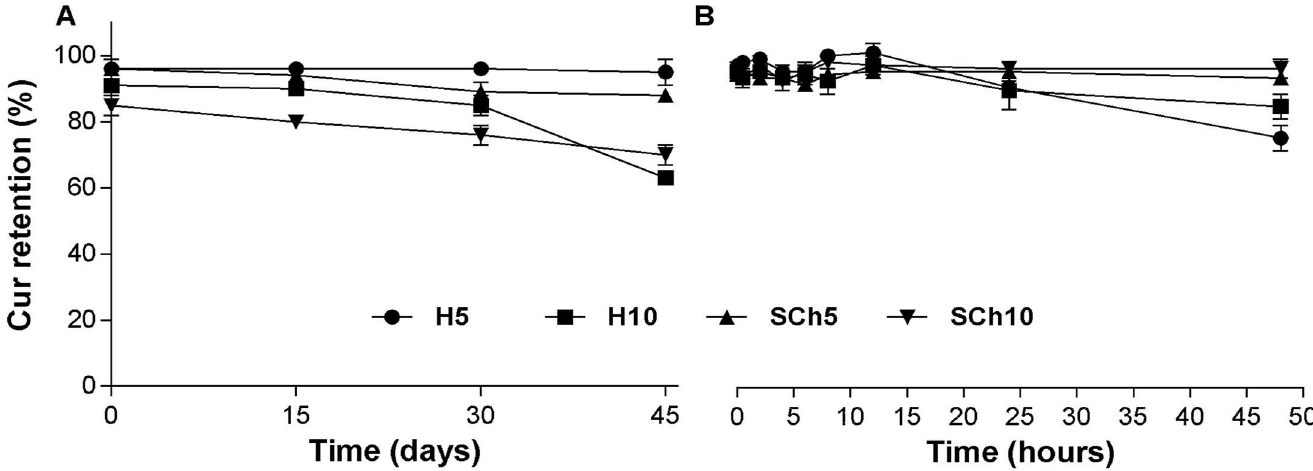
Fig 3. Stability of Cur-loaded liposomes over different storage times and temperature. Comparisonof the stability of H5, H10, SCh5 and SCh10 formulations at 4˚C ( A ) and at 37˚C ( B ). The results are shown as the mean ± SD of three replicates.